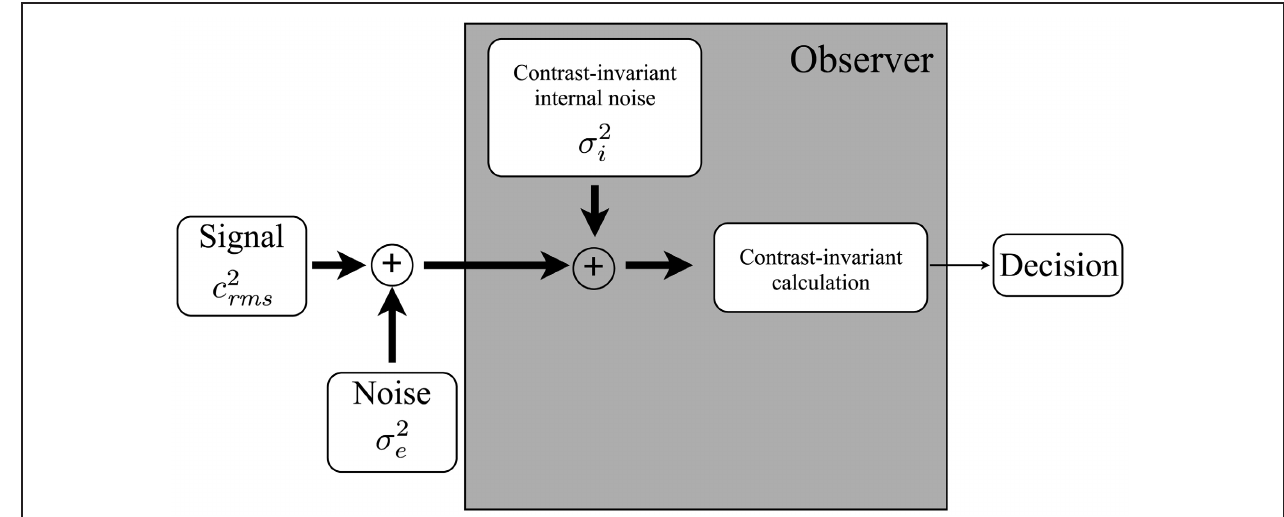
FIGURE 1 | A model of a human observer in a perceptual discrimination task. The observer (i) transduces a noisy external stimulus; (ii) adds an internally-generated noise; (iii) applies a calculation that transforms the internal representation into a decision